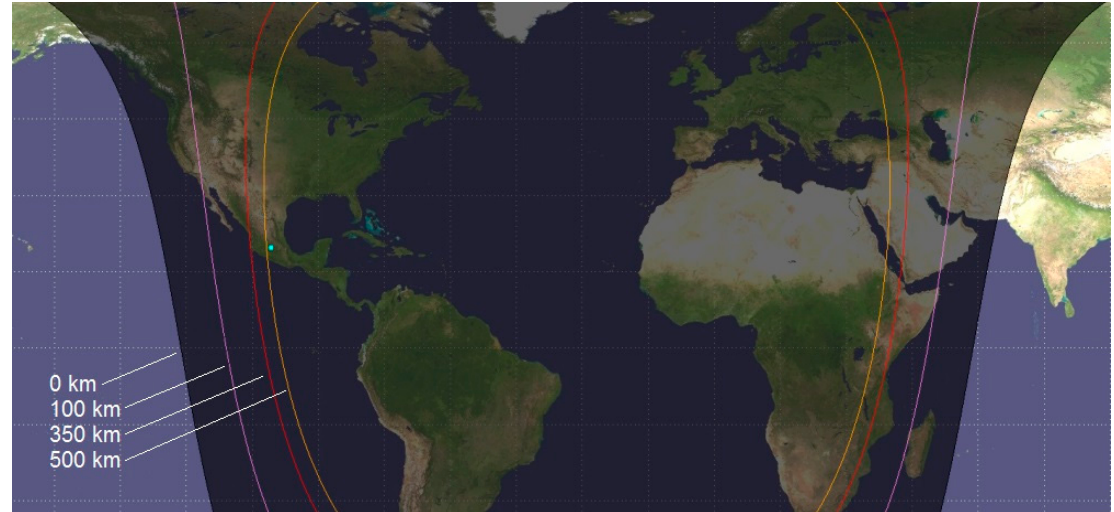
Figure 2. Terminator position at different heights at 02:18 UT on 19 February 2020. Blue dot indicates the meteoroid explosion site.